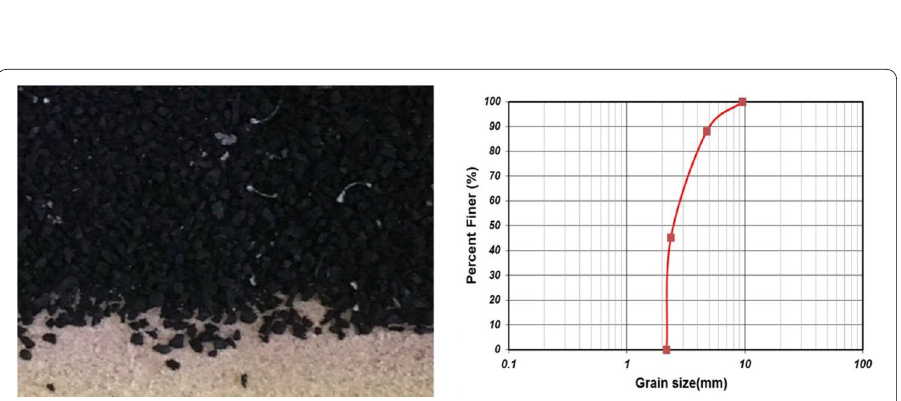
Fig. 6 General aspect and particle size distribution of the tire rubber particles